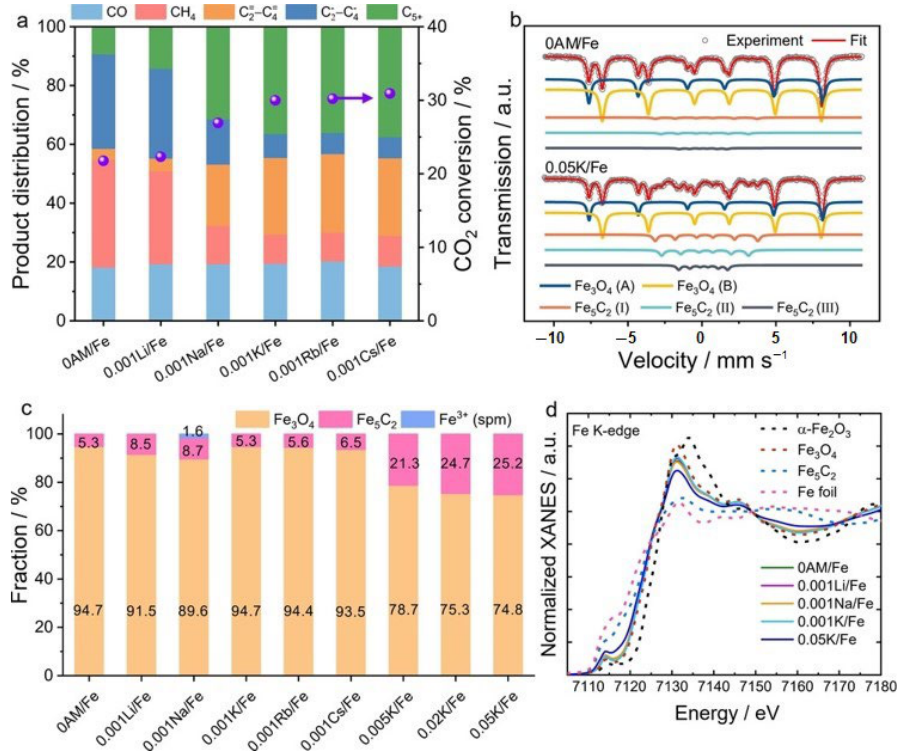
Figure 3. ( a ) CO 2 conversion and product distribution over 0AM/Fe and 0.001AM/Fe catalysts tested in CO 2 -FTS at 15 bar and 300 °C, using a feed 3 H 2 /CO 2 /0.3 N 2 with a GHSV of 1160 mL g cat − 1 h − 1 for 90 h. ( b ) Mössbauer spectra of spent 0AM/Fe and 0.05 K/Fe catalysts. ( c ) Composition of iron phases in spent catalysts as determined from Mössbauer spectra. ( d ) XANES spectra at Fe K-edge of spent 0AM/Fe, 0.001AM/Fe and 0.05 K/Fe catalysts. Reprinted with permission from ref. [91]. Copyright 2022 Wiley.